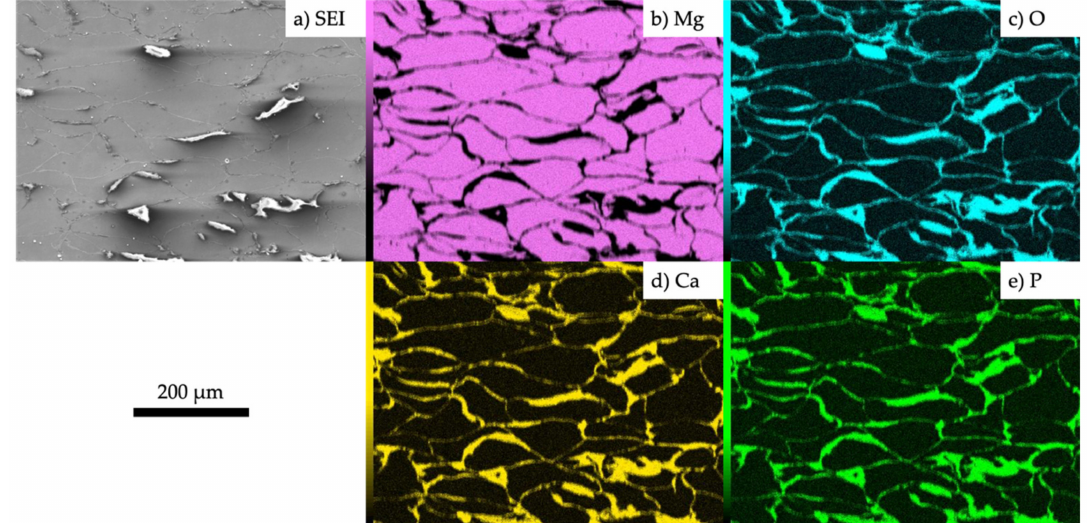
Figure 5. The elemental analysis of Mg–10HAP. ( a ) Secondary electron image (SEI) of the same area as analyzed by X-ray spectroscopy (EDS). ( b – e ) are the results of EDS mapping analysis showing Mg, O, Ca, P, respectively. The results indicated that the white lines are HAP as well as agglomerated white parts in